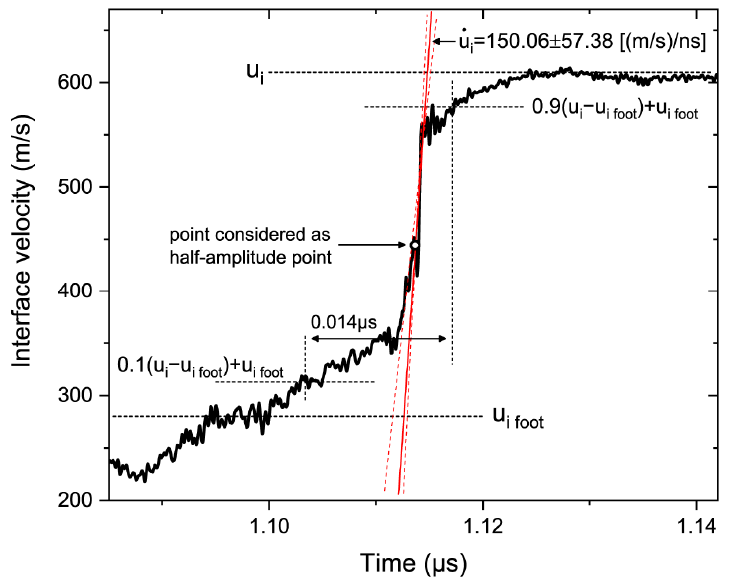
Figure 6. Actual calculations of the wavefront parameters in Experiment 5. The red solid line had a slope equal to the maximum velocity gradient; the dashed lines demonstrate the upper and lower boundaries of this value. The foot of the compaction wave chosen was somewhat arguable. The measured impact tilt in the experiment was 0.7 mrad.